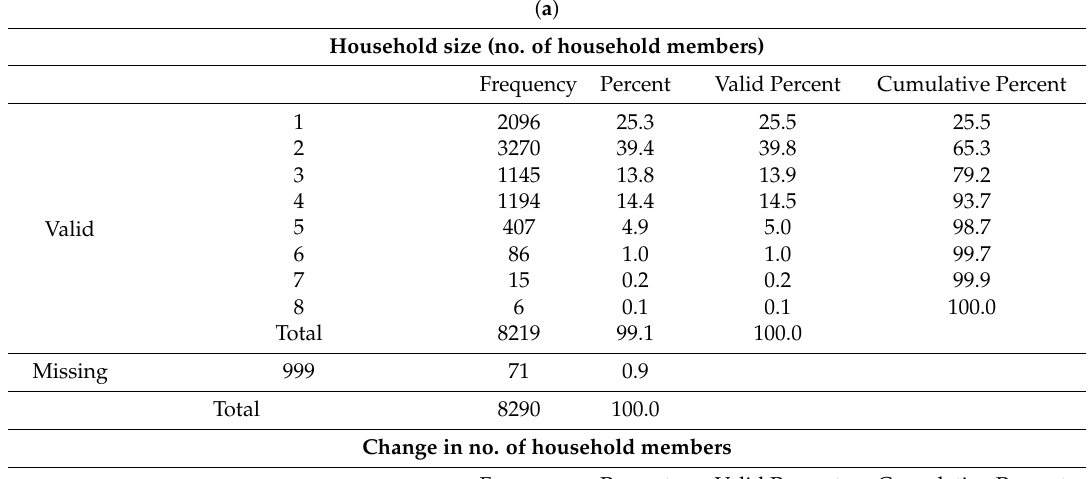
Table A1. ( a ) Socio-demographics of Enercoop. ( b ) Socio-demographics of Ecopower. ( a